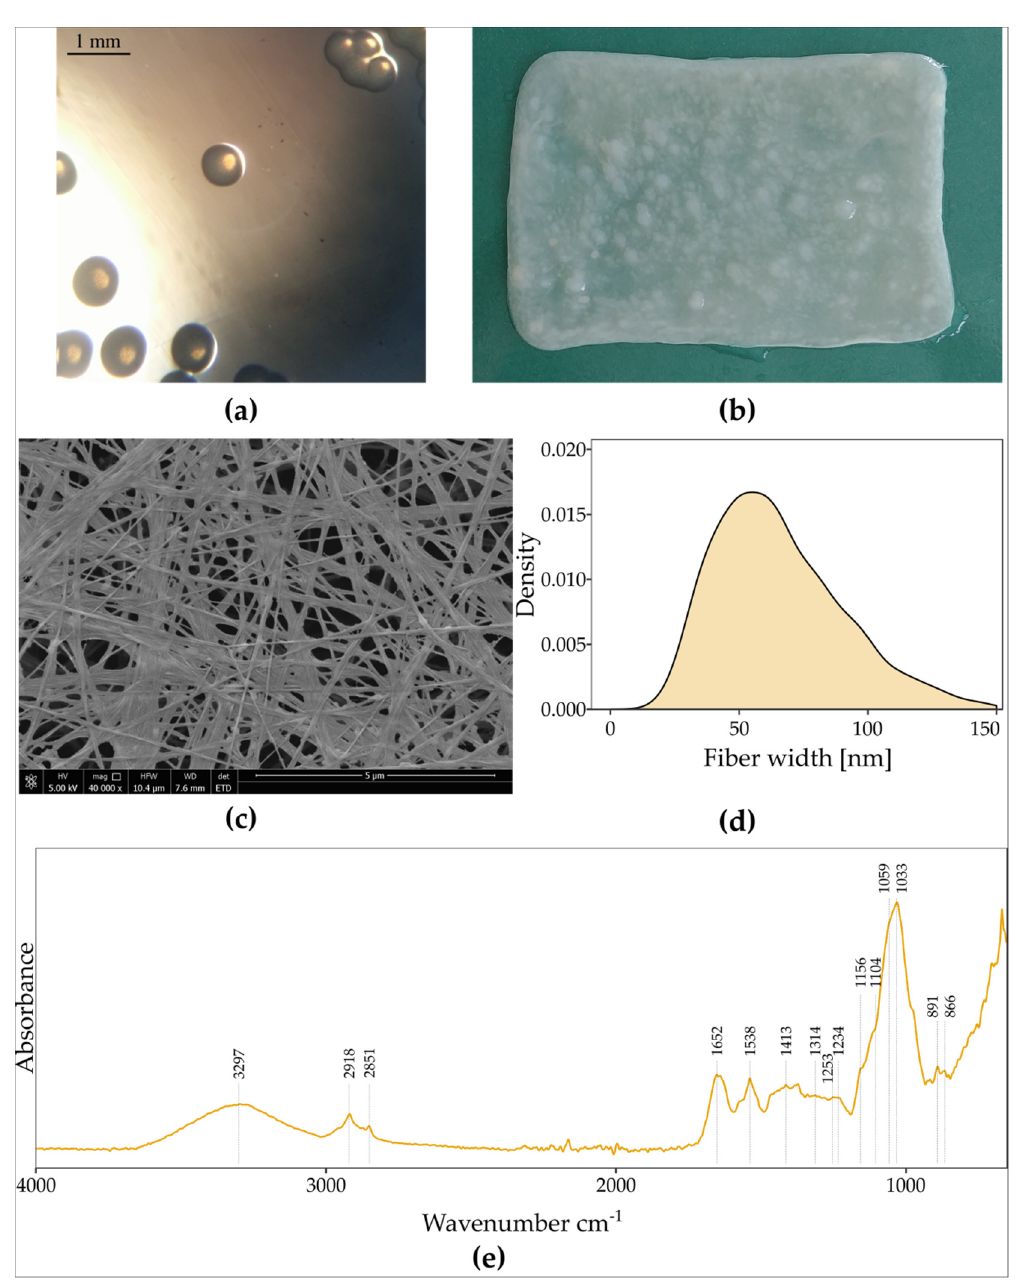
Figure 2. ( a ) Three-days colonies of K. hansenii SI1, ( b ) BNC membrane produced in SH medium, ( c ) scanning electron microscope image of BNC membrane produced in SH medium; the image was recorded at a magnification of 40,000× (bar—5 µm), ( d ) the probability density function of fibre width in BNC produced in SH medium and ( e ) FTIR-ATR spectrum of BNC produced in SH medium.